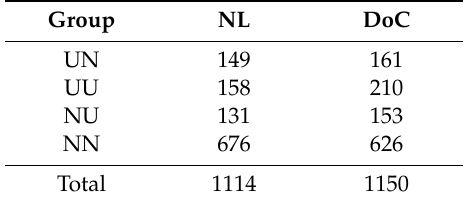
Table 1. Number of households according to NL or DoC use status in 2013 and